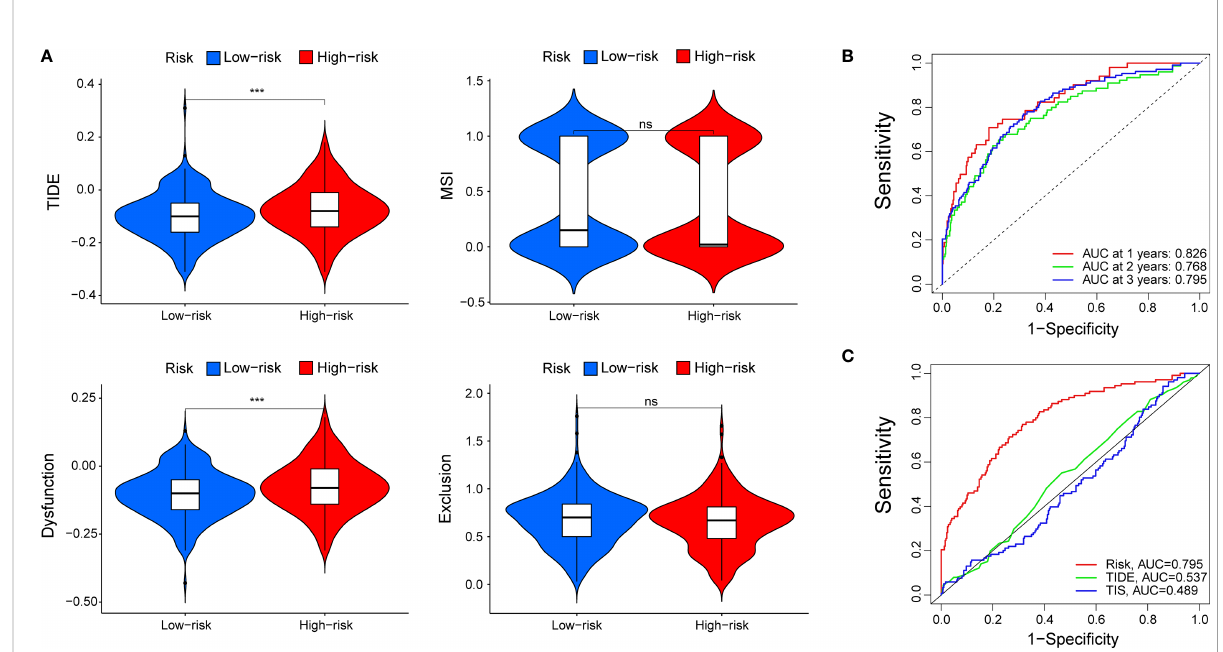
FIGURE 7 The prognostic value of the signature for patients with ccRCC. (A) TIDE, MSI, and T-cell dysfunction and exclusion score in different subgroups. The scores between the two subgroups were compared by the Wilcoxon test (ns, not signi fi cant; *** P < 0.001). (B) ROC analysis of our signature on OS at 1-, 2-, and 3-years follow-up. (C) ROC analysis of our signature, TIS, and TIDE on overall